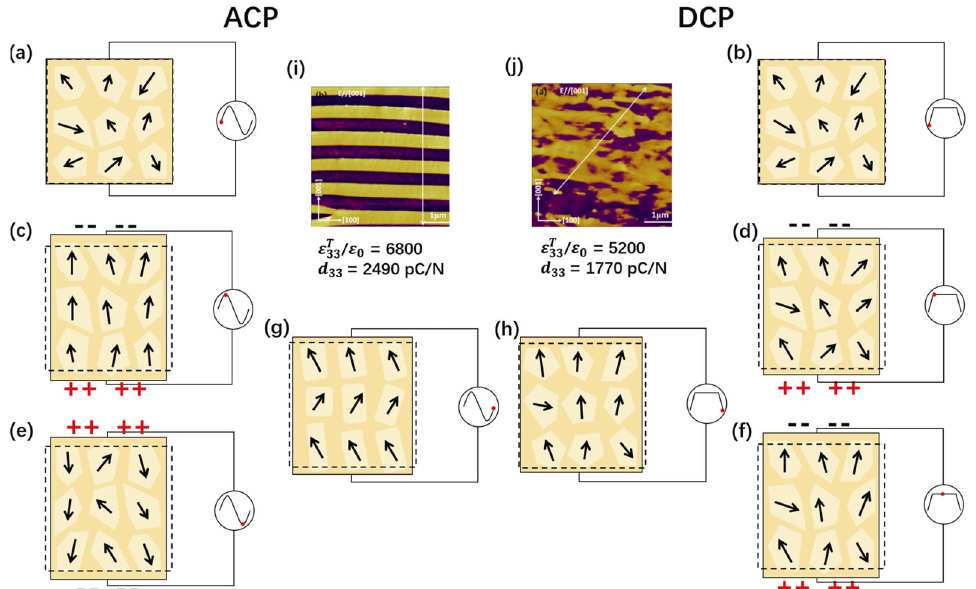
Fig. 5 Schematic images of (a), (c), (e), and (g) dynamic ACP and (b), (d), (f), and (h) static DCP processes; lateral phase of domain patterns observed on the fresh fracture of the ternary PMN-based SC after (i) ACP and (j) DCP. The PFM images are referred from He et al .